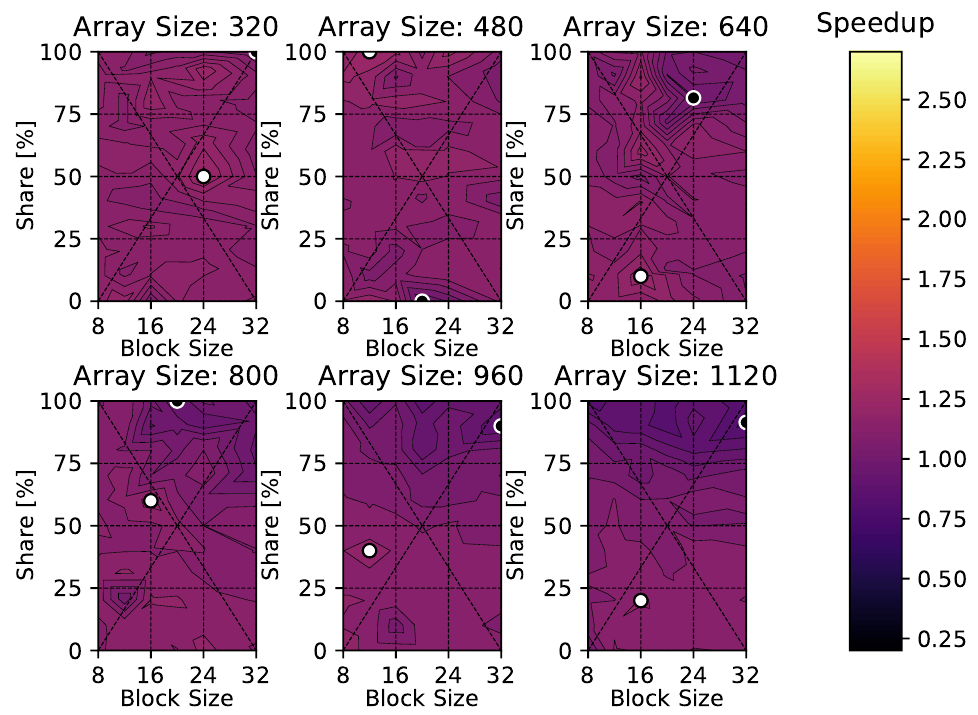
Figure 6. Swept rule speedup results for the heat diffusion equation with GeForce GTX 1080 Ti GPUs and Intel Skylake Silver 4114 CPUs.